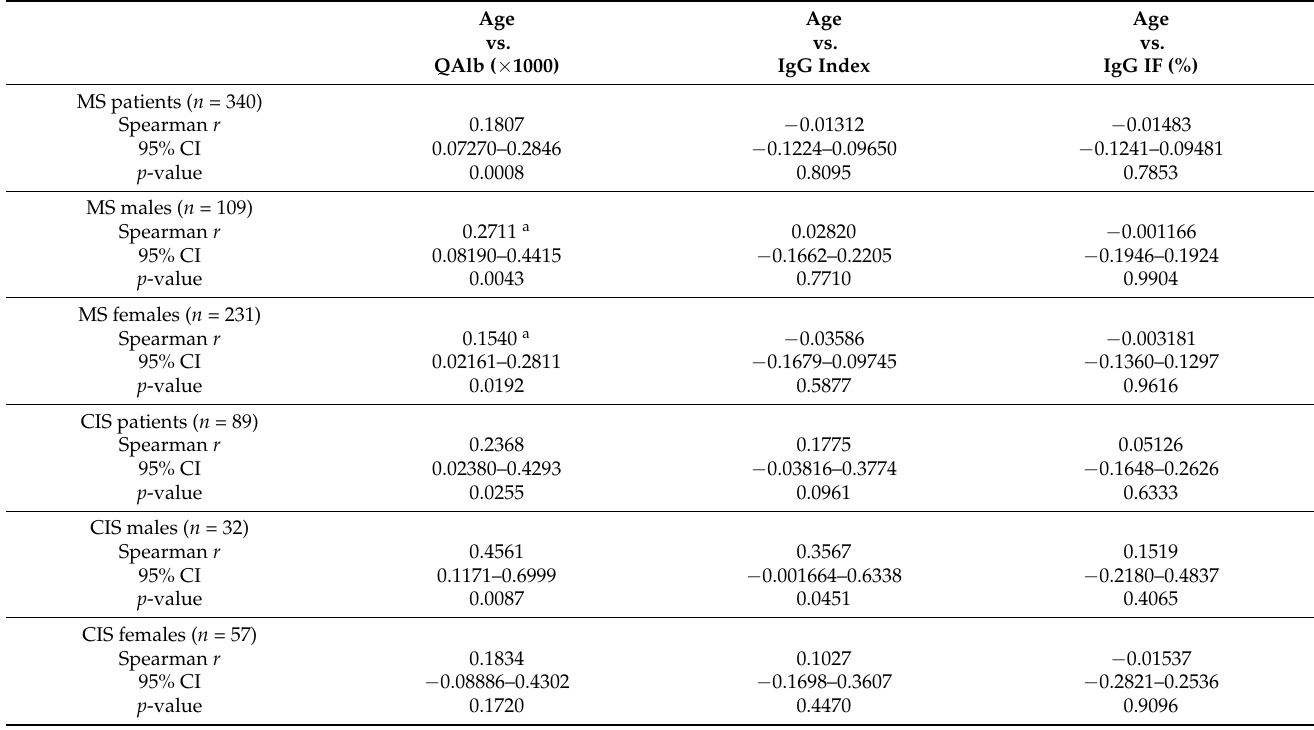
Table 4. Effect of age on quantitative cerebrospinal fluid (CSF) indexes. Albumin quotient